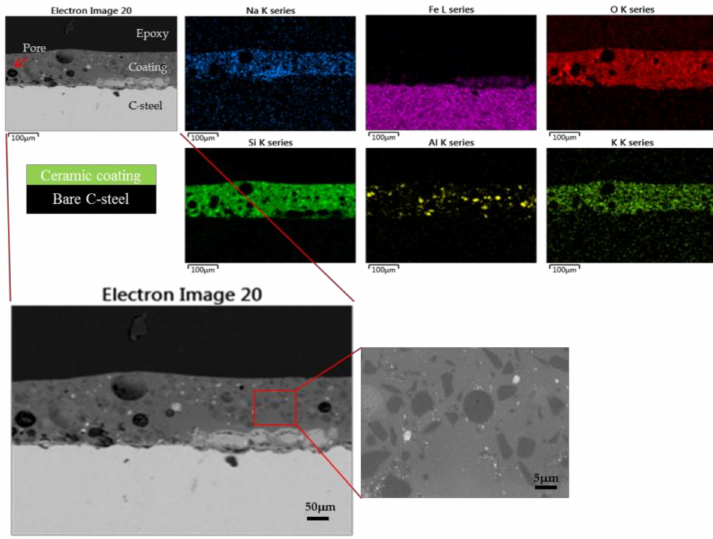
Figure 5. Morphology and EDS maps for the cross-section of the ceramic coating.